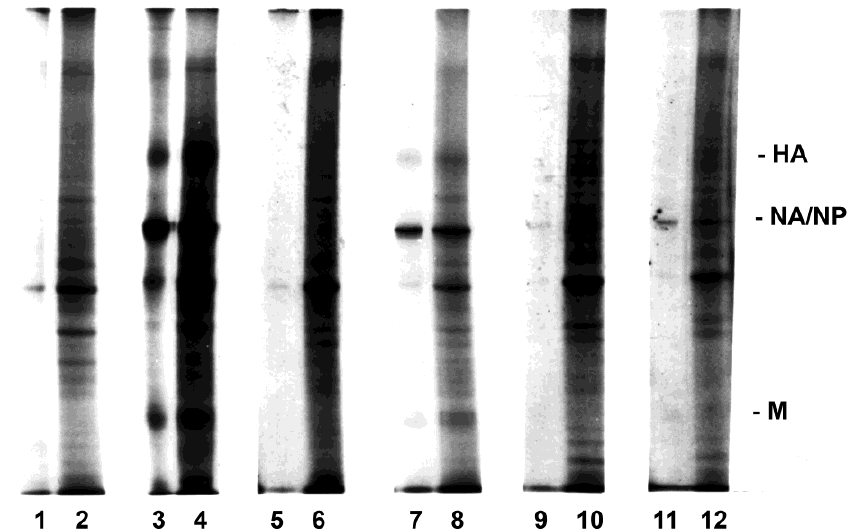
Figure 2. Influenza virus infection of purified PBMC subpopulations. Autoradiogram of proteins from purified human macrophages (lanes 1–4), total lymphocytes (lanes 5–8), and CD4 + (lanes 9 and